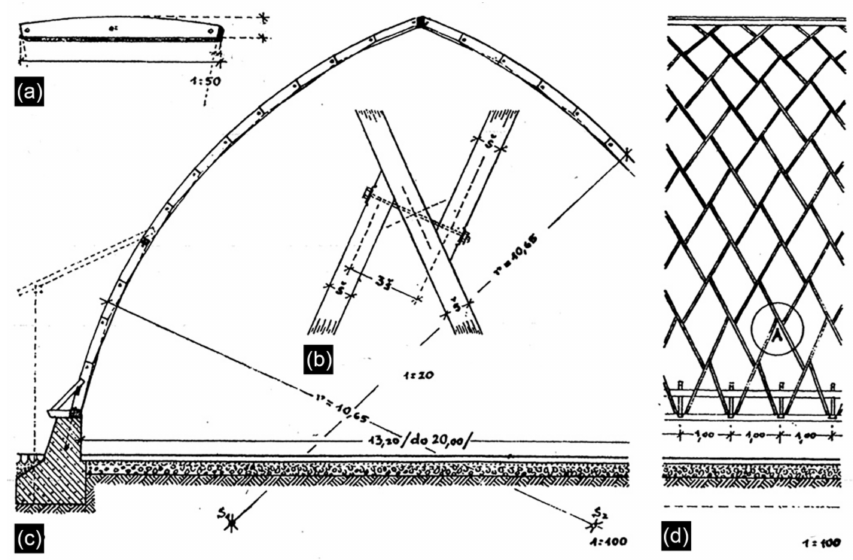
Figure 2. Zollinger lamella roof design: ( a ) lamella detail with dimensions, ( b ) joints of lamellae, ( c ) transverse section and ( d ) longitudinal section of the roof for housing